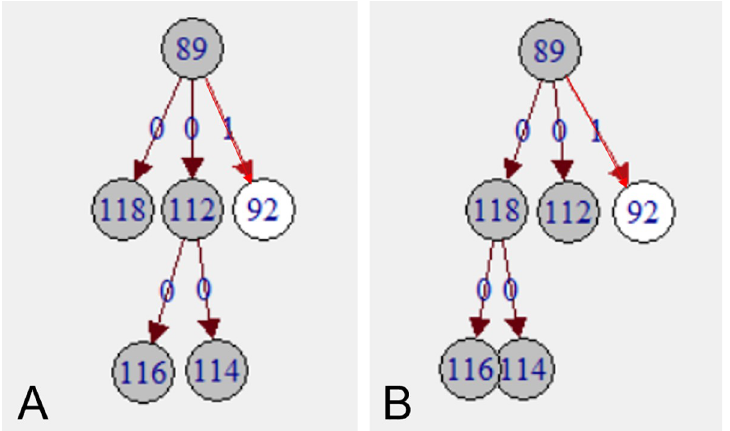
Fig 3. Reconstructed transmission trees. Transmissions are depicted by edges and isolates by vertices in a directed network. Edge labels and edge colour indicate number of SNPs of differences between ancestor and descendant. (A) and (B) two alternatives of potential infection chains of five isolates with identical genotype (dark grey). More alternatives